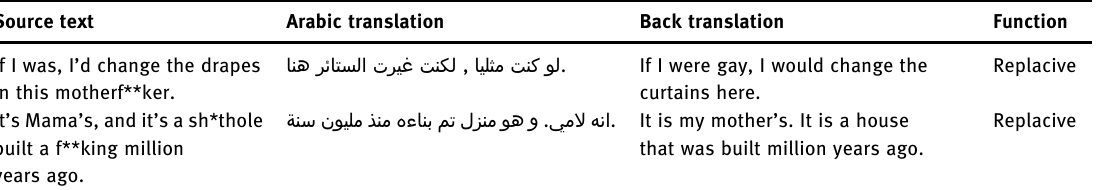
Table 14: Replacive – swearing Source text Arabic translation Back